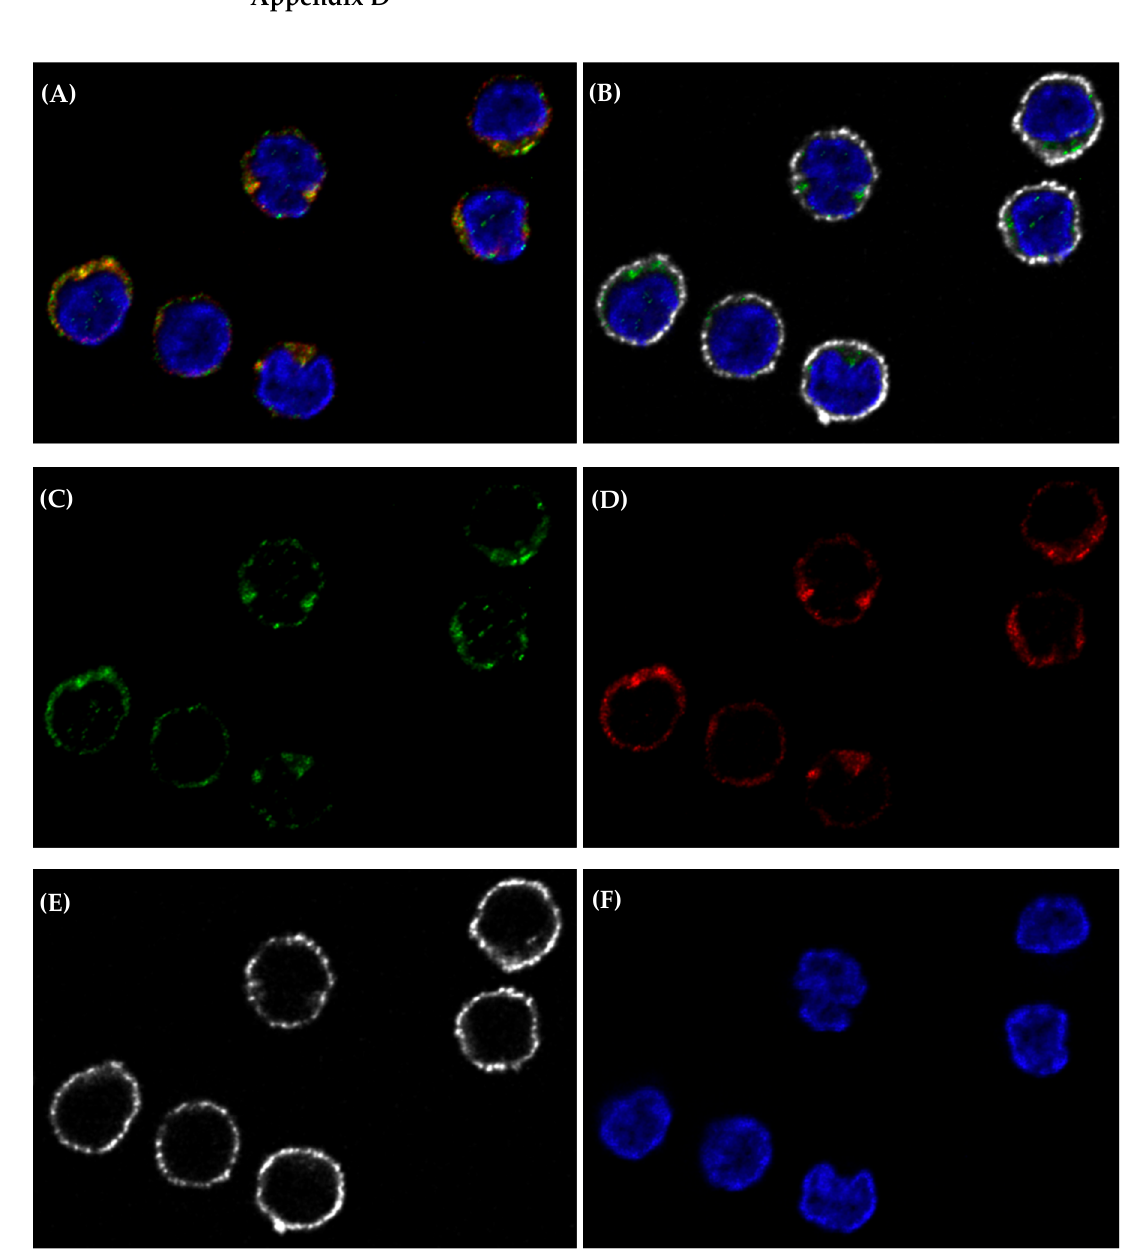
Figure A4. Representative composite images of NK cells from a HC following pharmacomodulation of TRPM7. Co-localisation of TRPM7 (green) with ( A ) PIP 2 (red) and ( B ) actin (white) with the nucleus in blue. Individual images of ( C ) TRPM7, ( D ) PIP 2 ( E ) actin ( F ) nucleus also presented. Abbreviations: natural killer (NK), transient receptor potential melastatin 7 (TRPM7), phosphatidylinositol 4,5-bisphosphate (PIP 2 ).